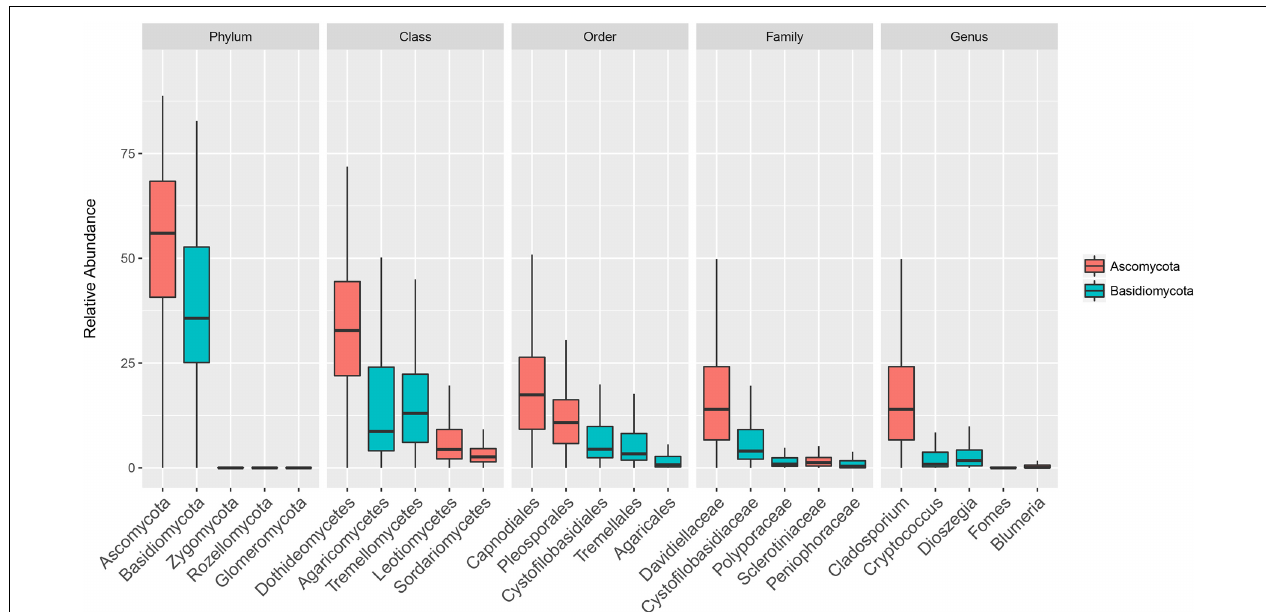
FIGURE 2 | Boxplot showing total relative abundance of reads of the five most abundant taxa at Phylum, Class, Order, Family and Genus levels in 152 rooftop air samples from 2012 and 2013 in Rothamsted, UK, Slagelse, DK, and Wageningen, NL. Upper, middle and lower lines represent first quartiles, medians and third quartiles. The whiskers represent a 1.5 ∗ inter-quartile